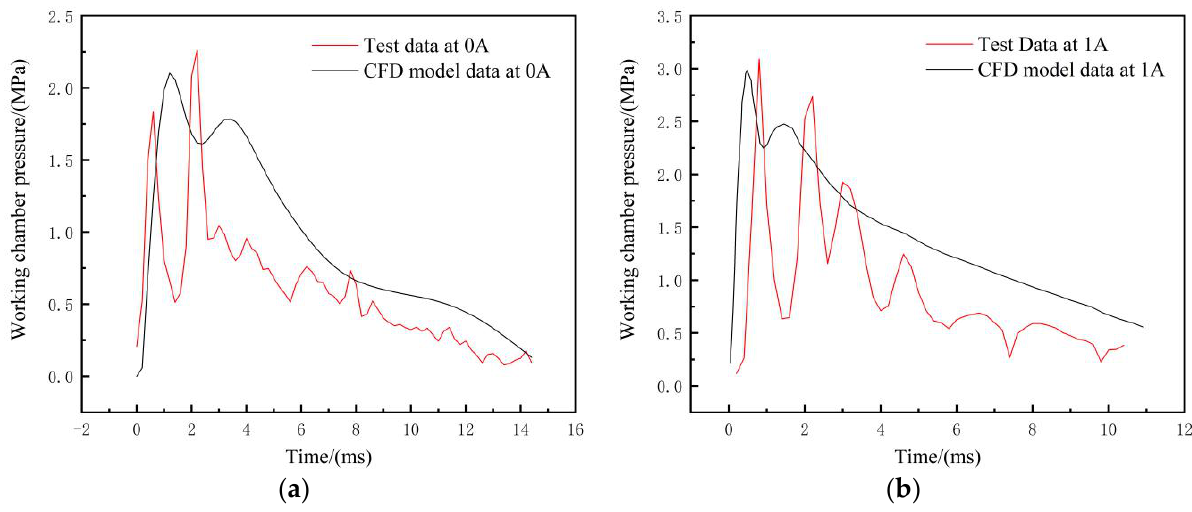
Figure 26. Comparison of test and simulation data. ( a ) Data comparison at 0 A; ( b ) data comparison at 1 A.